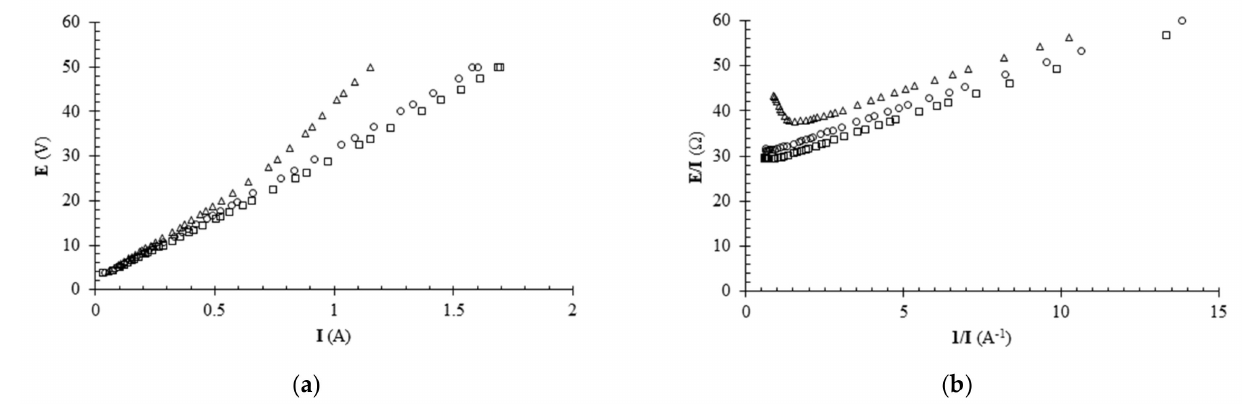
Figure 2. Voltage-current (E-I) curves ( a ) and corresponding Cowan and Brown plot ( b ) for aque- ous citric acid solutions at three different citric acid concentrations ( ∆ = 0.9 g/L; (cid:3) = 23.9